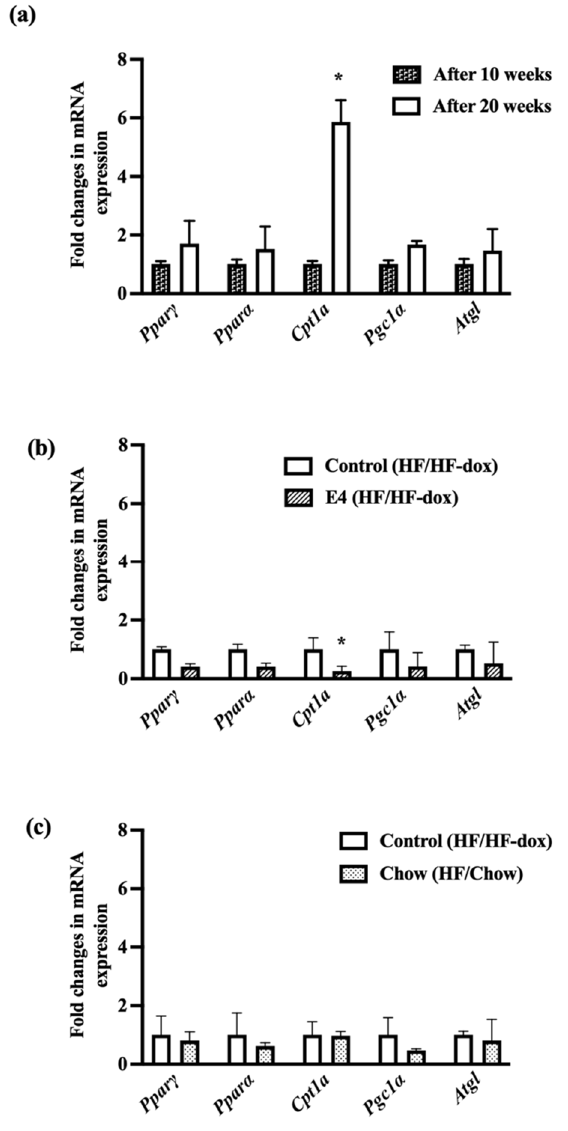
Figure 6. Fold changes in mRNA expression of genes involved in fat oxidation and lipolysis. Control mice show significantly increased expression of Cpt1a from 10 weeks to 20 weeks of HFD feeding ( a ); however, E4 mice show significantly reduced expression of Cpt1a ( b ), while diet reversal in chow mice showed no difference in fat oxidation ( c ). n = 5 Welch’s t -test: * p < 0.05.